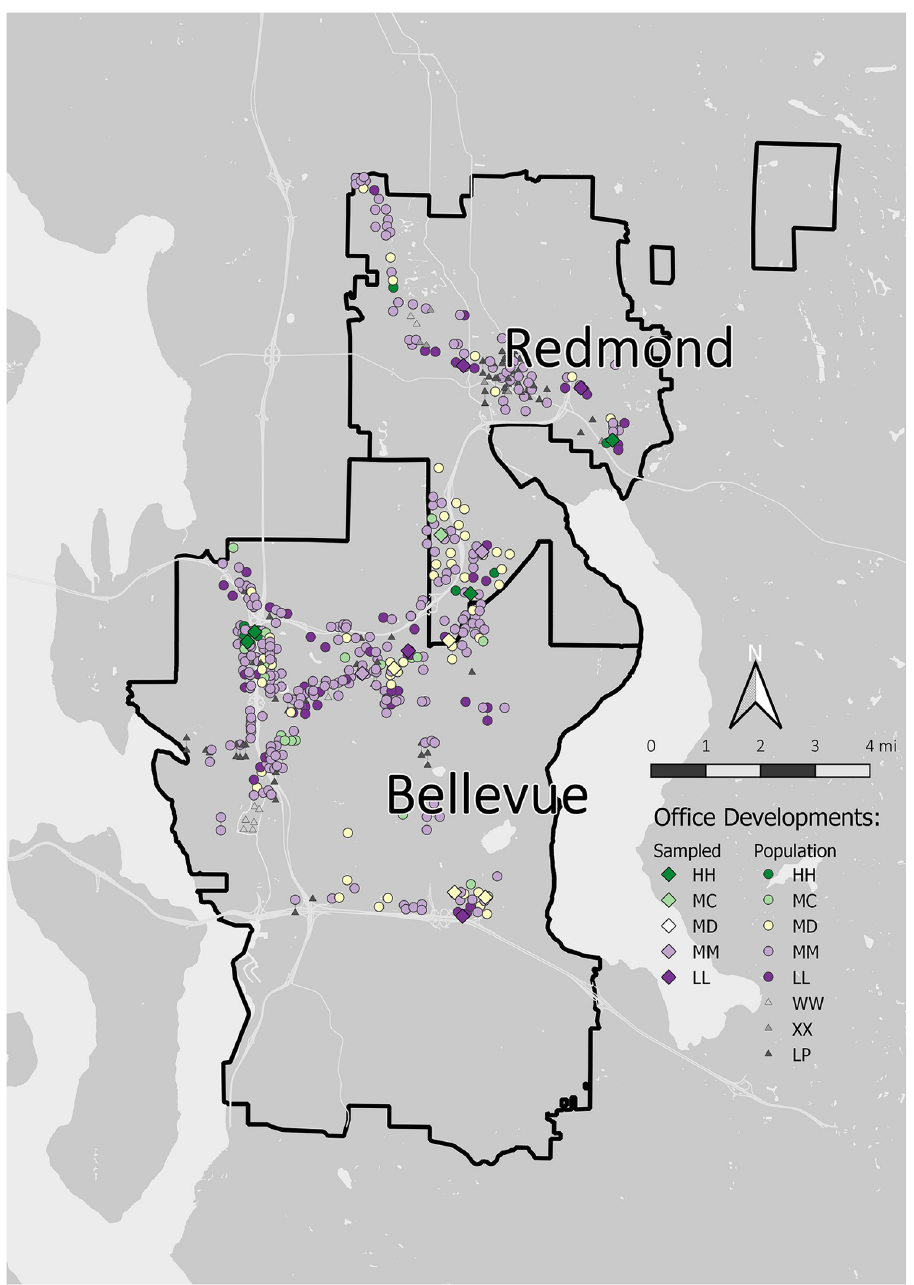
Fig 2. Map of office development study sites in Redmond and Bellevue, Washington. The population of office developments with High (HH), Medium Canopy (MC), Medium Diverse (MD), Medium (MM), and Low (LL) vegetation types are represented with colored circles; excluded sites (no vegetation/LP, wetlands/WW, and under construction/XX) are represented with gray triangles. Sampled sites are shown with colored diamonds.